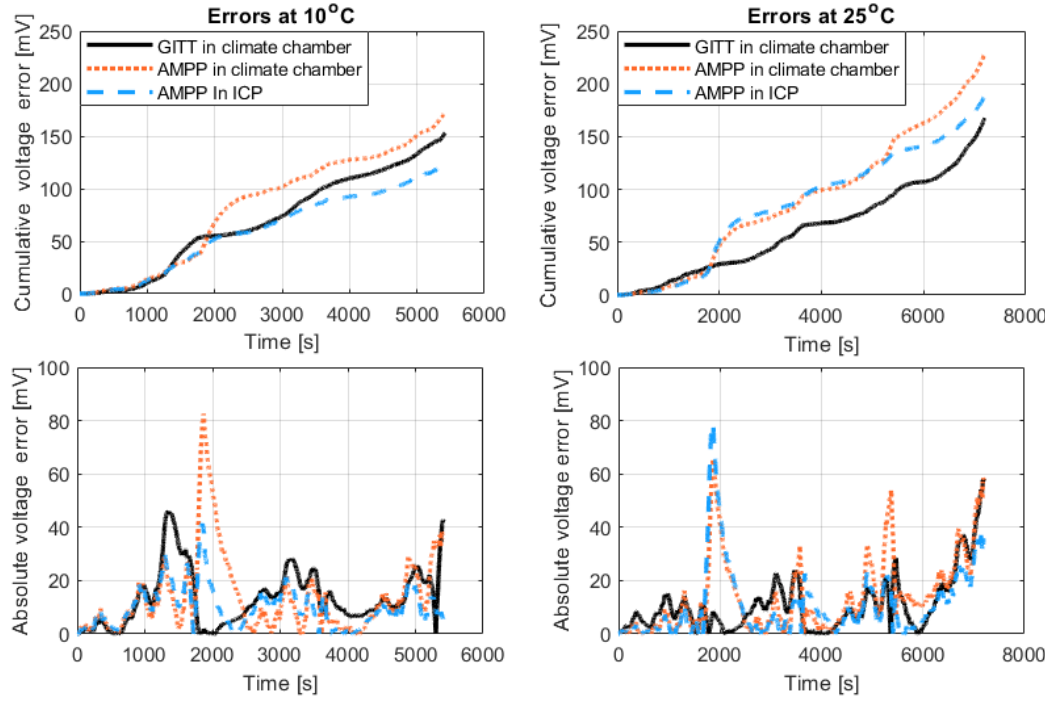
Figure 7. Comparison of error between the experimental data and the model parameterised using different experimental techniques at 10 °C and 25 °C. The cumulative absolute voltage error ( top ) and the absolute voltage error ( bottom ). To ease the visualisation of the major trends in the graph, a moving average with a window size of 200 and sampling rate of 2 Hz was applied.